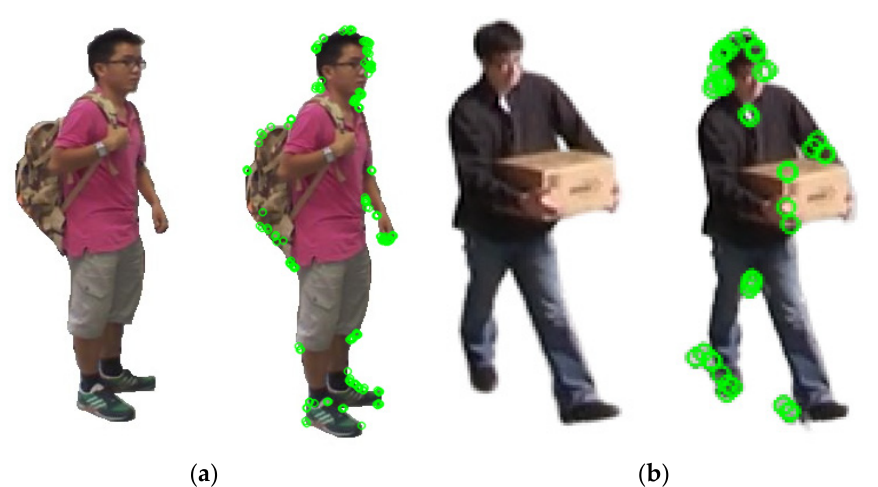
Figure 6. ORB feature points of silhouettes from the SYSU 3D HOI and VIRAT Video datasets, including ( a ) wearing backpack—full silhouette ( left ) and its ORB feature points ( right ) and ( b ) carrying an object—full silhouette ( left ) and its ORB feature points ( right ).